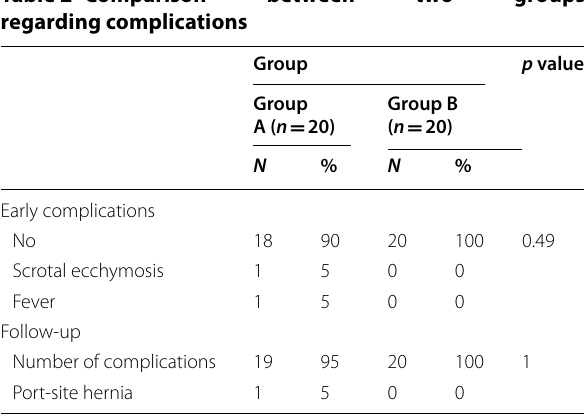
Table 2 Comparison between two